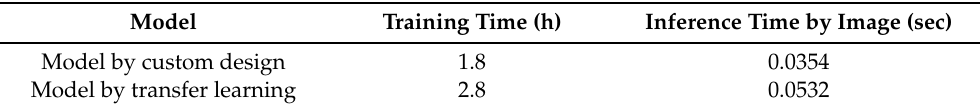
Table 9. Comparison of the two proposed models in terms of training and validation times, h is hours, sec is